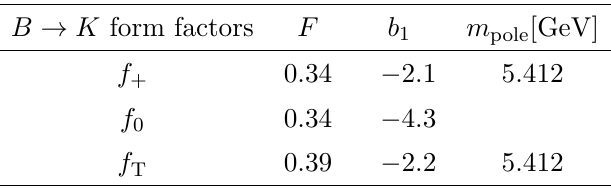
Table 5 . Central values of the F and b 1 parameters and resonance masses m pole , entering in the evaluation of the B ! K form factors f + ; 0 ;T for the B ! K transitions, as provided in [15]. For the f 0 form factor no resonance mass is